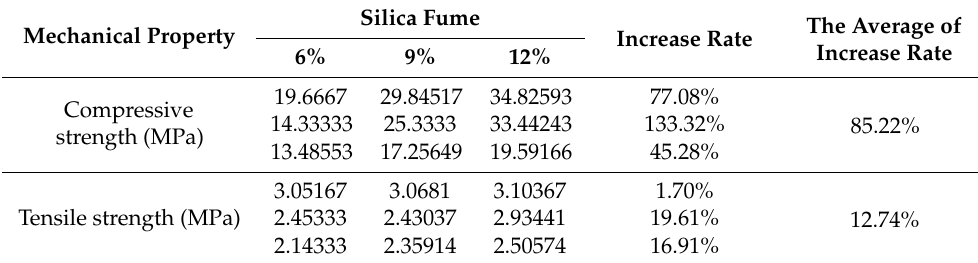
Figure 7. The influence of SF on mechanical properties. ( a ) is the influence of SF on the compressive strength. ( b ) is the influence of SF on the tensile strength. Table 6. The increase rate of different mechanical properties.